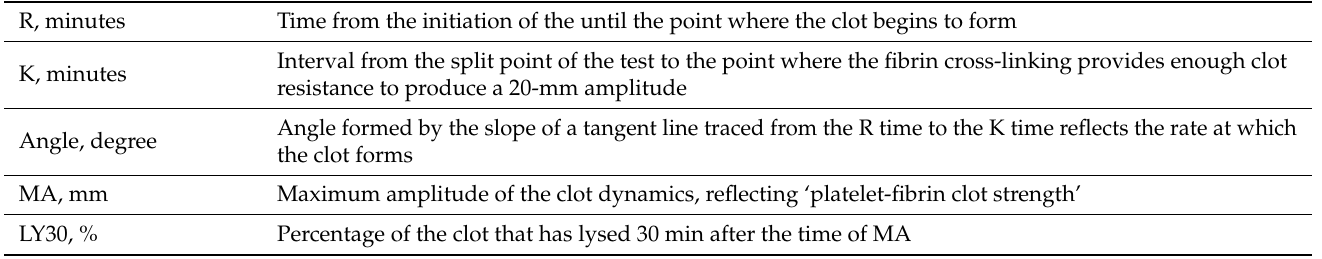
Table 1. Thromboelastographic